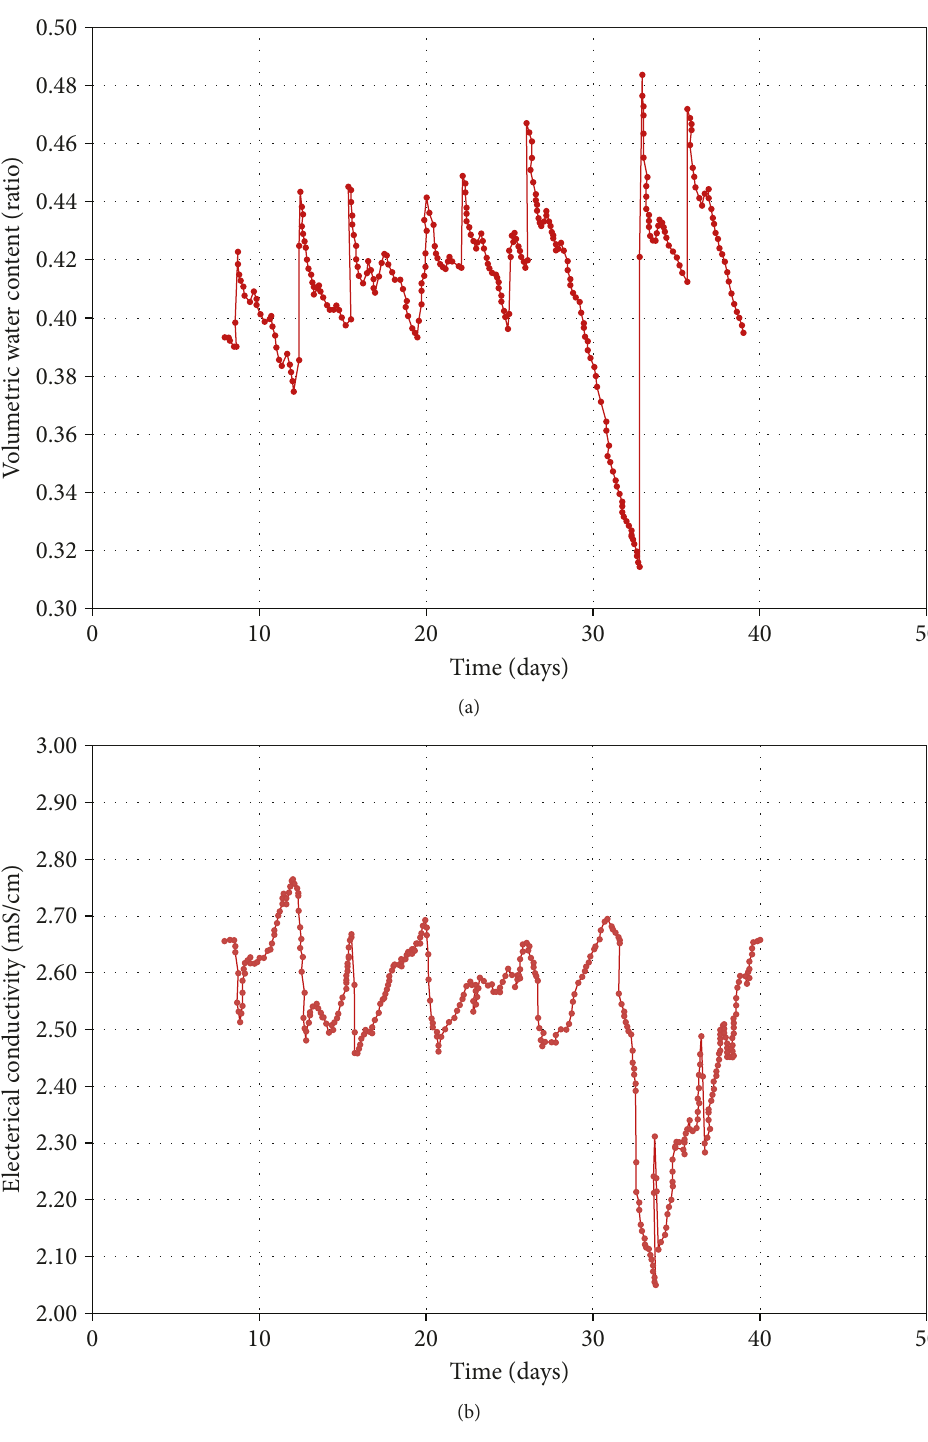
Figure 5: (a) Moisture pro fi le over 30 days and (b) electrical conductivity pro fi le over 30